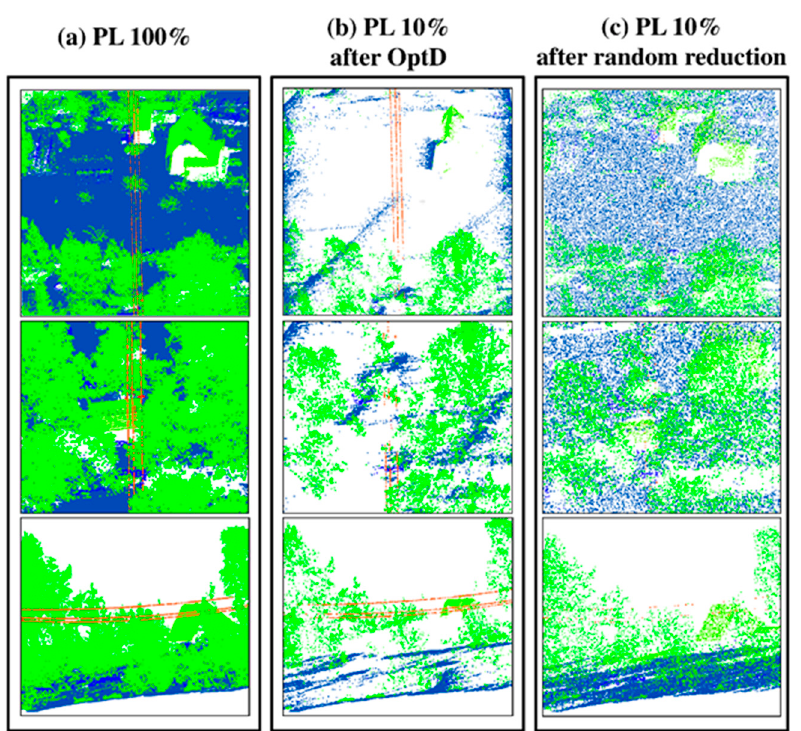
Figure 11. Fragments of the ALS dataset including power lines: ( a ) original, ( b ) after OptD method, ( c ) after random reduction.